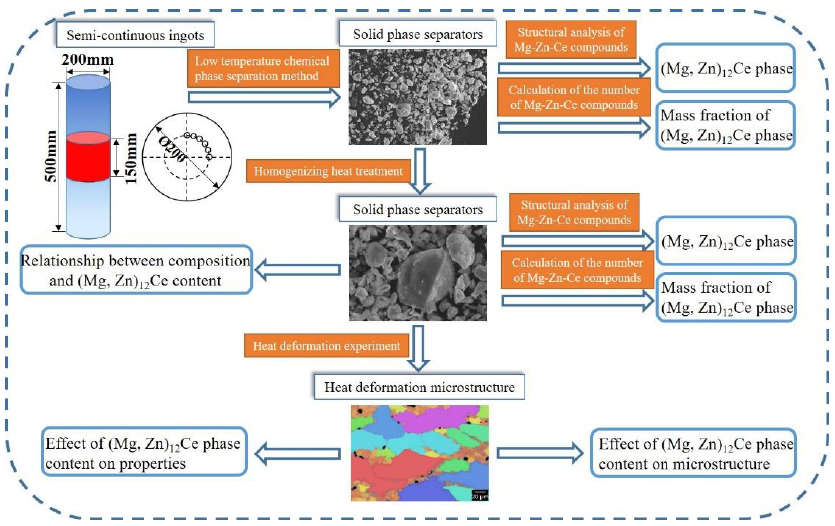
Figure 1. SEM microstructure images of the as-cast